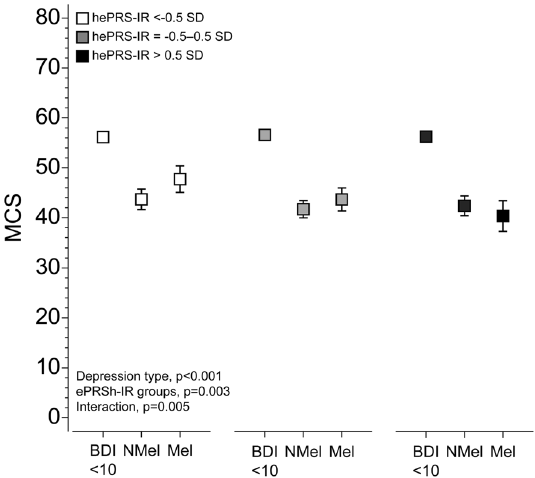
Figure 1. The association of the types of depression and mental component score of the SF-36 according to the high/medium/low scores of the biologically informed hippocampal polygenic risk score for the insulin receptor gene network (hePRS-IR). Model adjusted for age, sex and population stratification, smoking, alcohol usage, socioeconomic class, body mass index, leisure-time physical activity and comorbidities. MCS mental component score of the SF-36, hePRS-IR biologically informed hippocampal polygenic risk score for insulin receptor, SD standard deviation, BDI Beck Depression Inventory, BDI < 10 no depression, NMEL non-melancholic depression, Mel Melancholic